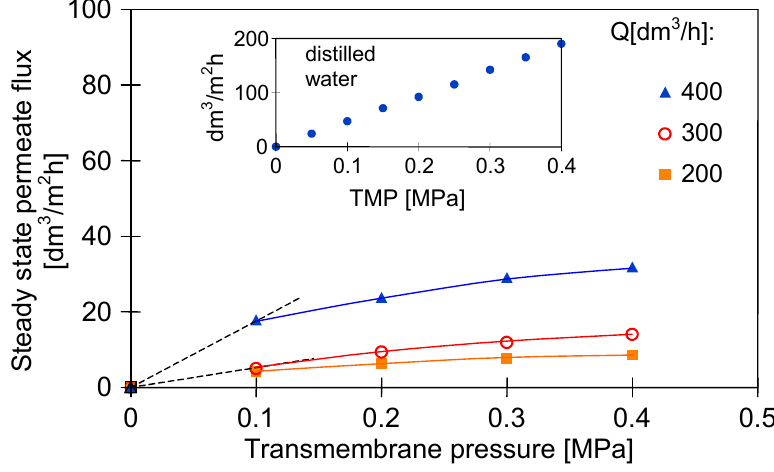
Figure 4. The impact of transmembrane pressure and feed flow rate on the steady-state permeate flux.